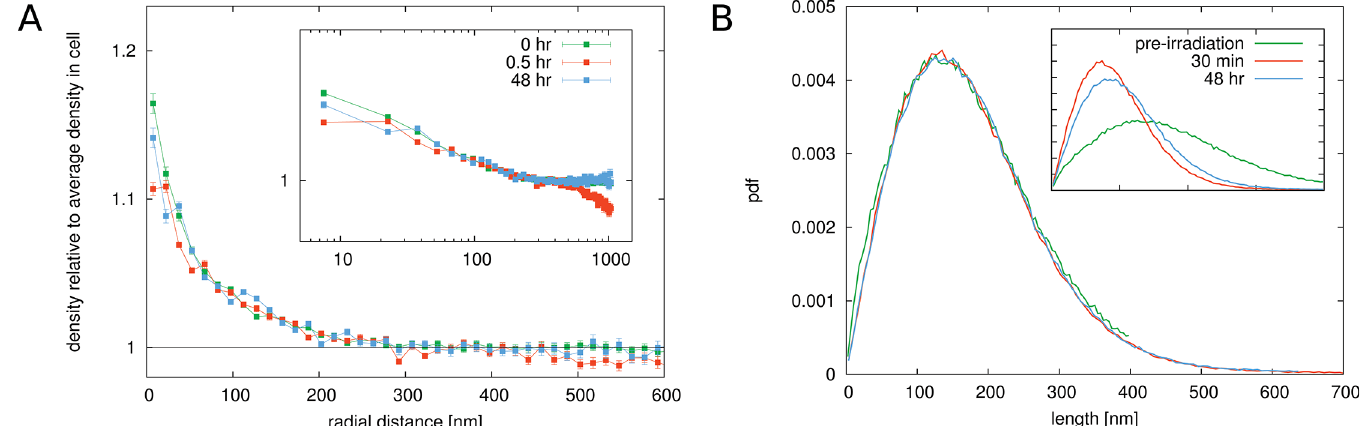
Fig 4. Results for cells exposed to 0.5 Gy radiation. Panel A. Radial pair correlation functions determined at different repair times after exposure to 0.5 Gy radiation dose. The radial pair correlation function g ( r ) shows that correlations between the positions of labeled H2B histones exist up to a distance of roughly 300 nm. Marker and thus chromatin densities in the surroundings of each marker are elevated compared to the average density of markers in the cell nucleus. Above 300 nm, however, histone positions are uncorrelated and the marked histones can be viewed as being positioned randomly relative to each other. Furthermore, the radial pair correlation function for cells exposed to 0.5 Gy γ -irradiation apparently does not differ from the one of untreated cells, regardless of the time passed after irradiation. Panel B. Rescaled distribution of the length of edges in a Delaunay triangulation of the H2B marker positions after different repair times post 0.5 Gy irradiation. The inset shows the original distributions for the different images. The differences in the edge length distributions are due to the different marker densities in the images. Therefore a rescaling of the distributions was performed with respect to the point density to clear out this effect. The rescaled distributions can be seen in the main panel and show that the distributions belong to the same